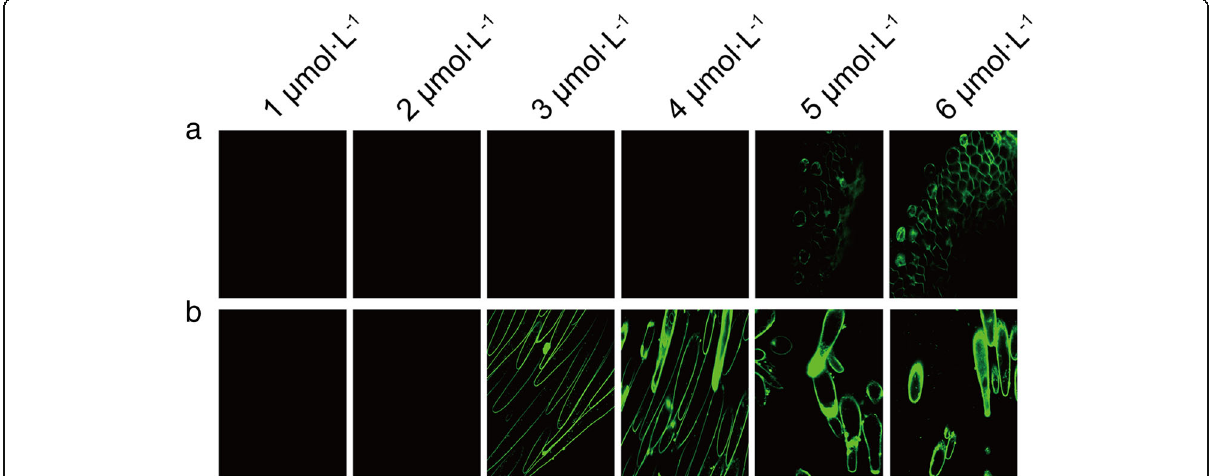
Fig. 3 Optimized the di-4-ANEPPDHQ staining parameter for cotton fiber cells. a Di-4-ANEPPDHQ dye treatment for 3 min. b Di-4-ANEPPDHQ dye treatment for 5 min. 1 μ mol·L − 1 , 2 μ mol·L − 1 , 3 μ mol·L − 1 , 4 μ mol·L − 1 , 5 μ mol·L − 1 , and 6 μ mol·L − 1 indicate the treatment concentrations